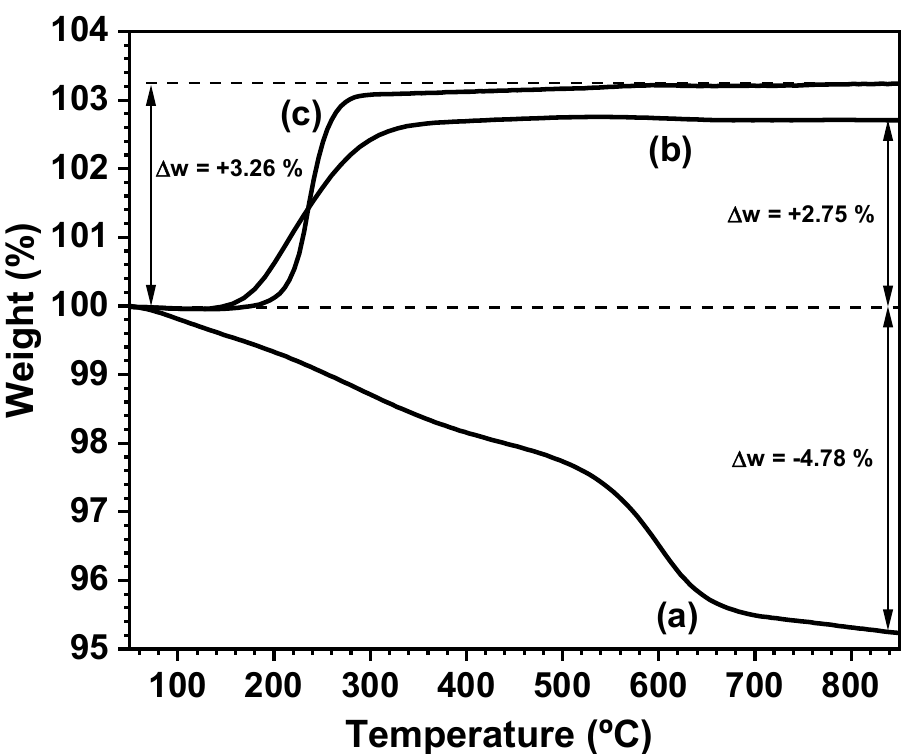
Figure 4. Thermogravimetric curves of ( a ) PBMO-m sample in flowing Ar, ( b ) PBMO-m + 900 °C/Ar sample in flowing air and ( c ) PBMO-m + 1100 °C/Ar sample in flowing air.